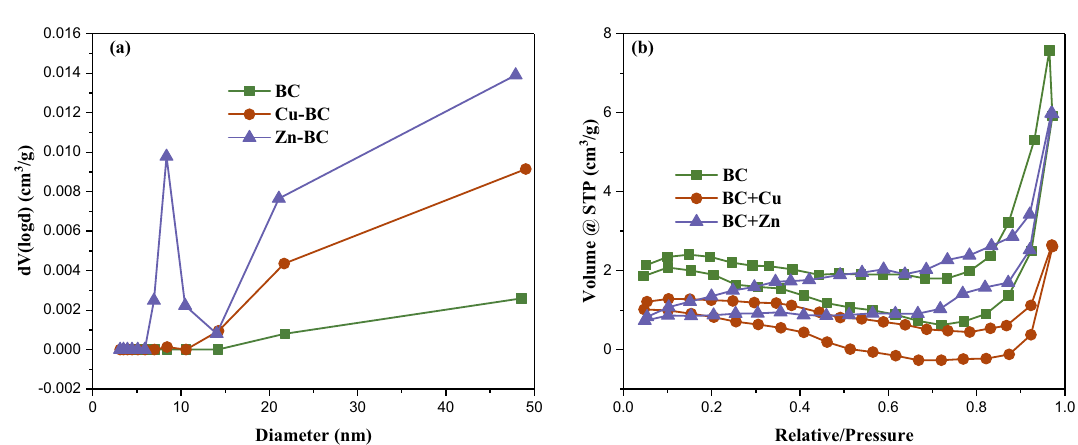
Figure 10. ( a ) The pore diameter distribution curves of BC, Cu-BC and Zn-BC; ( b ) N 2 adsorption–desorption curves of BC, Cu-BC and